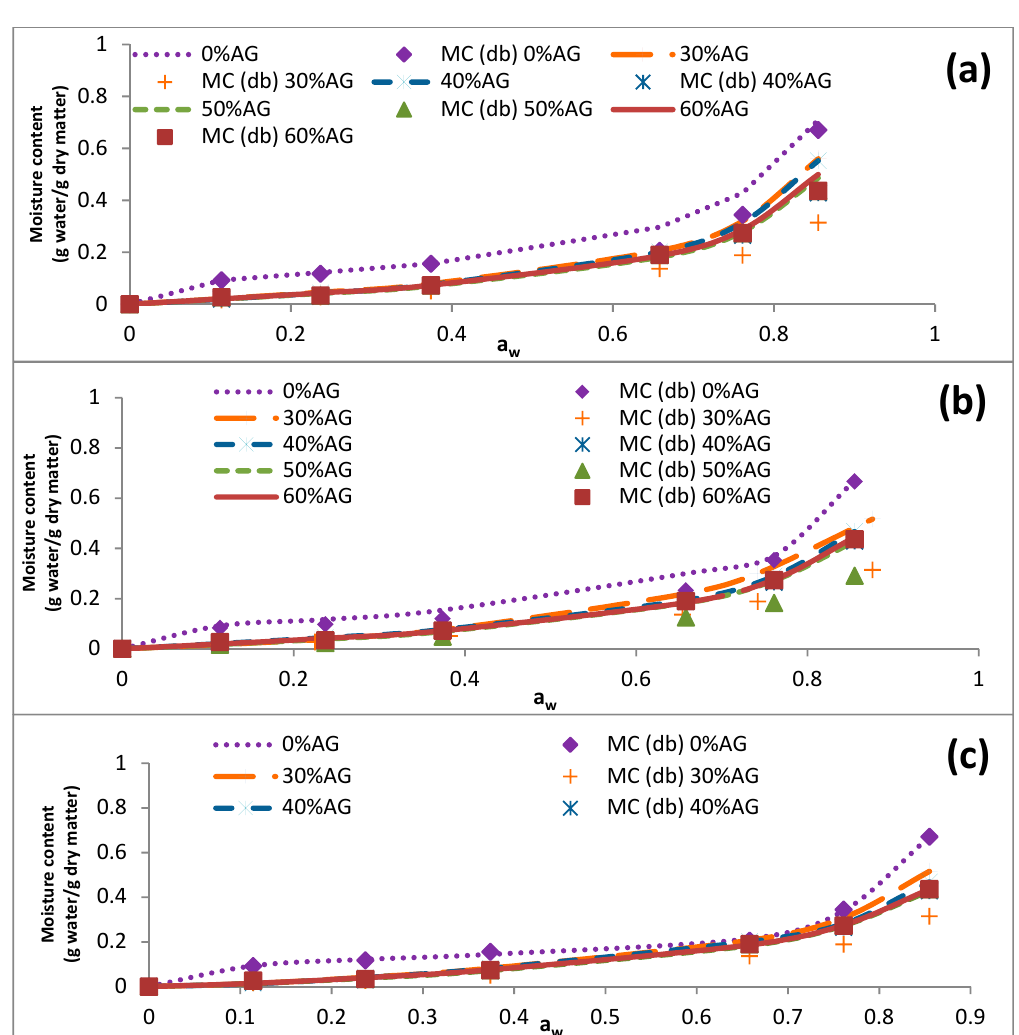
fitting the experimental data into mathematical models are presented as lines. ( a ), ( b ), and ( c ) represent the obtained data from BET, GAB, and Peleg models. 0% AG: 100% DS-0% AG; 30% AG: